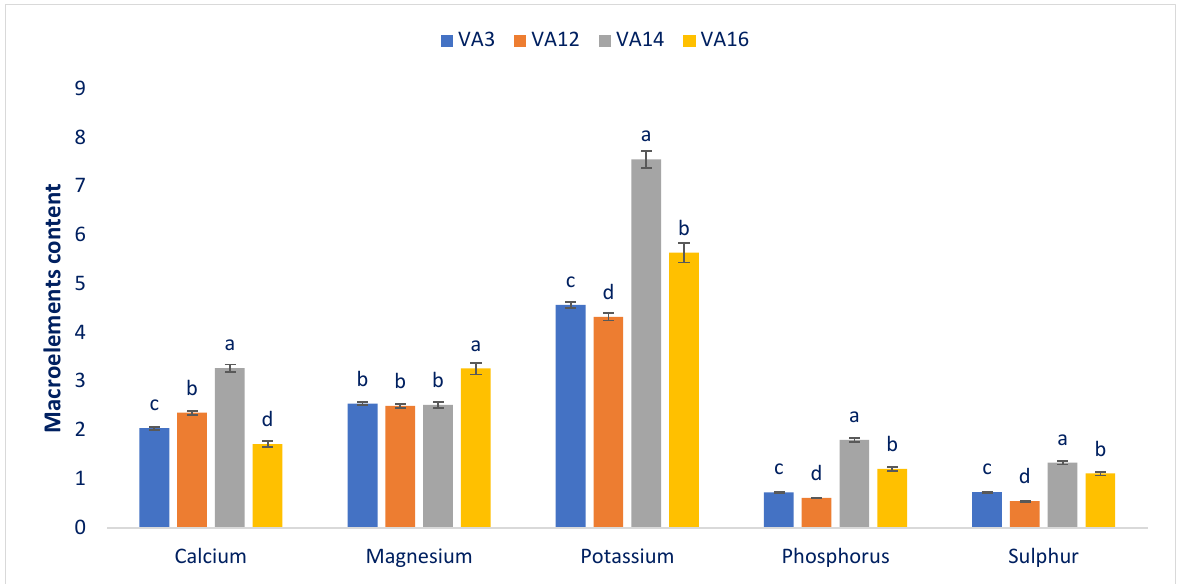
Figure 2. The microelement contents (mg g −1 FW) in four drought-resistant accessions of amaranth. Dissimilar letters indicate statistical significance according to (DMRT) ( p < 0.01), ( n = 3).